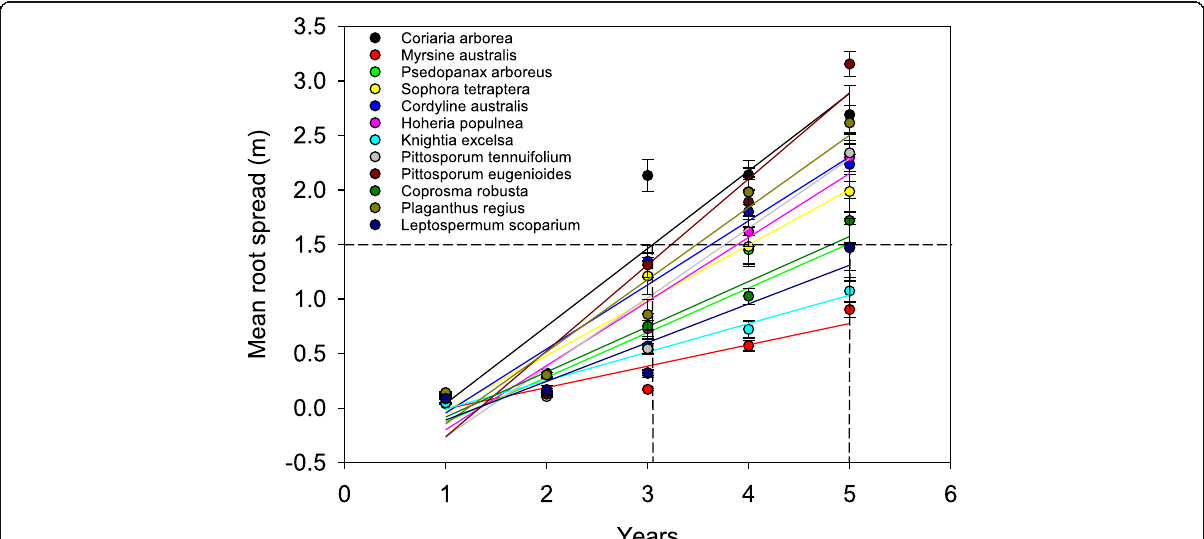
Fig. 6 Time required for roots of plants at 3 × 3 m spacing (1100 stems ha − 1 ) to overlap. Error bars represent the standard error of the mean. The line at 1.5 m indicates which species and the year their lateral roots extended half the distance between